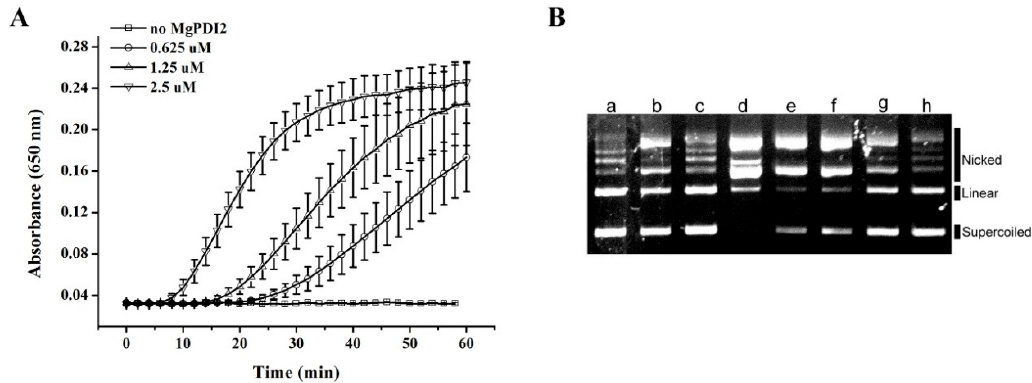
Figure 3. The 12% SDS-PAGE analysis of the purified MgPDI2 expressed in Escherichia coli BL21 (DE3).